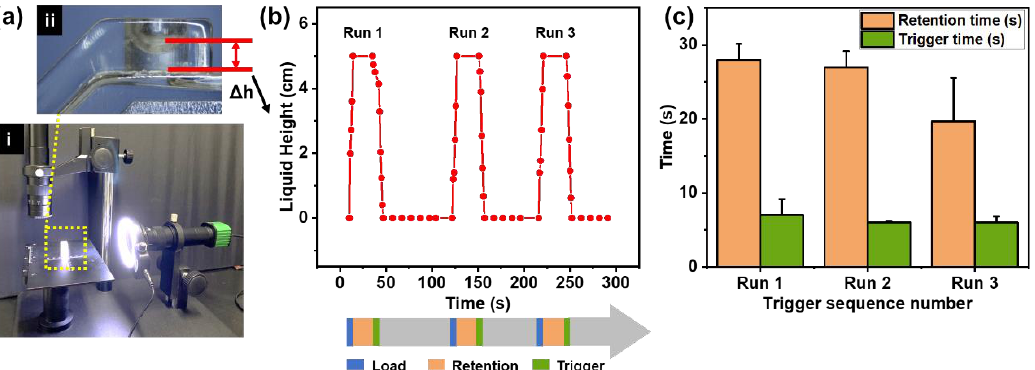
Figure 6. Performance characterization of the 3D trigger valve with repeatable retention-trigger cycle. ( a ) Setup diagram. ( b ) Liquid height variation in three times repeatable retention-trigger cycle. ( c ) The time required for three repetitions to retain and trigger.